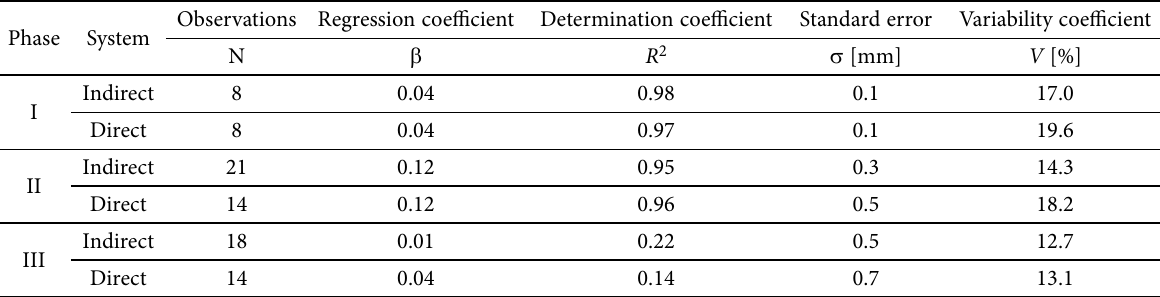
Table 2. Calculated regression coefficients and indicators of model representativeness